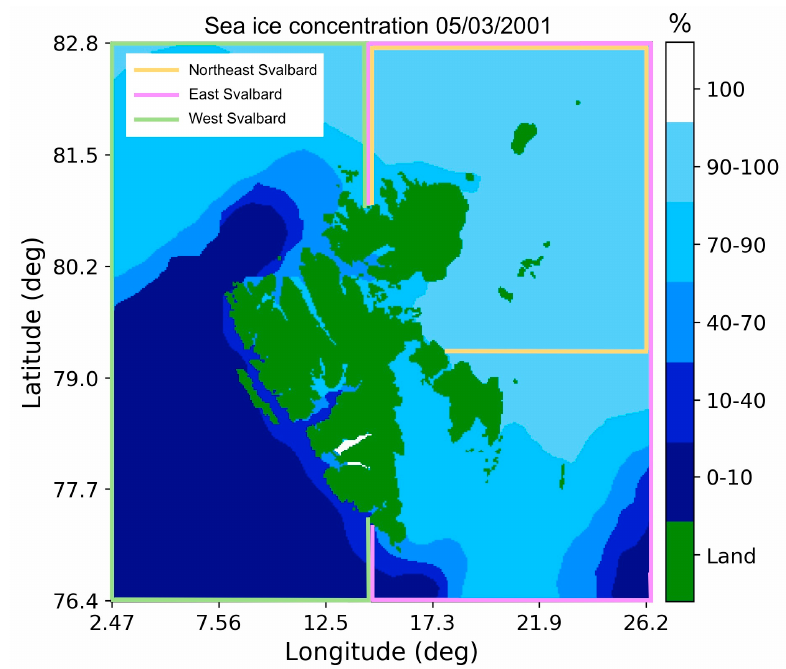
Figure 3. Example of the sea ice concentration around Svalbard on 5 March 2001. The yellow, pink and green colored boxes indicate the subregions of data that are averaged and correlated with the snow cover fraction dataset.